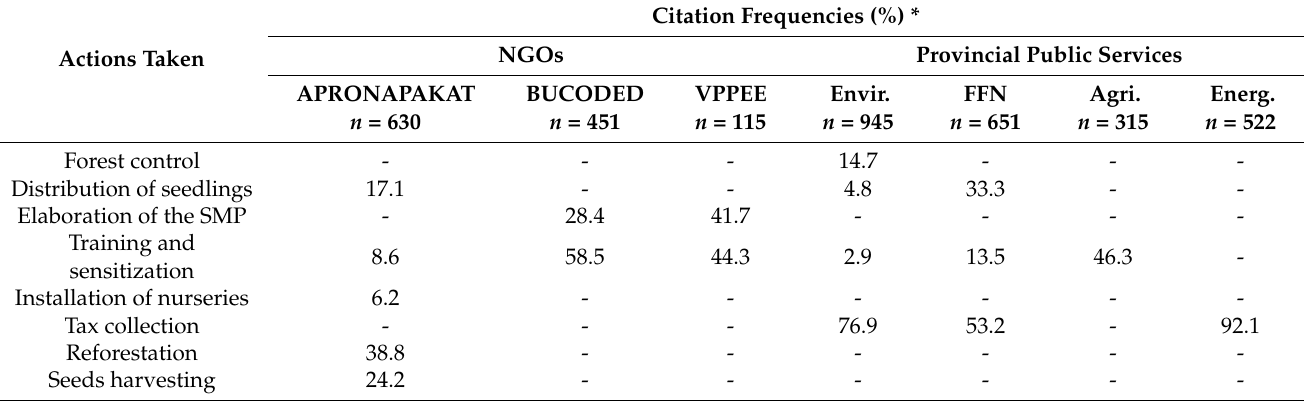
Table 5. Actions of NGOs and provincial public services, as perceived by local communities in the different villages of the rural area of